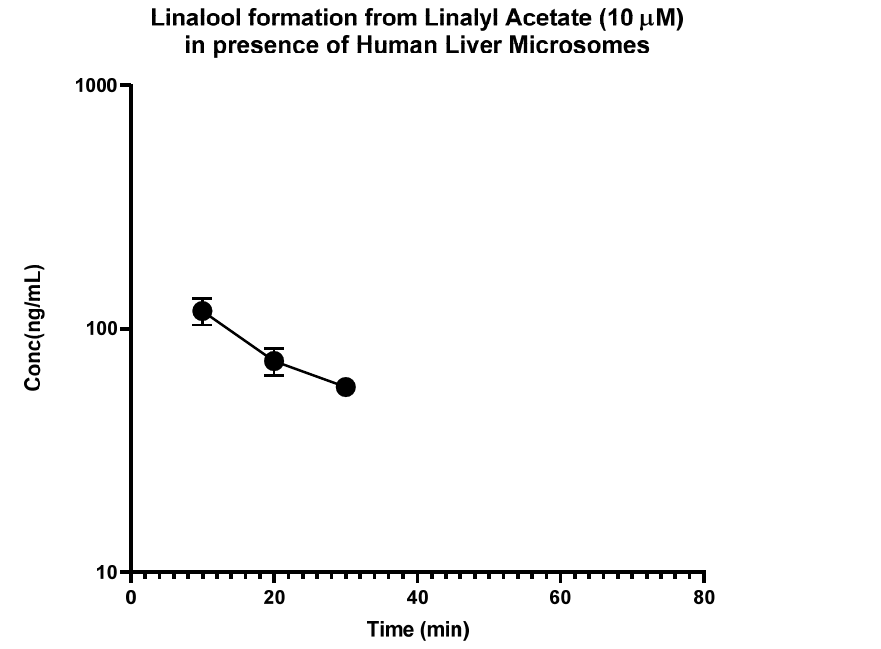
Molecules 2023 , 28 , x FOR PEER REVIEW Figure 2. Time-dependent metabolic depletion of linalool, linalyl acetate, and 7-hydroxy coumarin in human S9 fractions. Human S9 fractions were incubated with linalool, linalyl acetate, and 7-hydroxy coumarin (10 µ M) for 0–120 min in the presence of cofactors. The data are expressed as mean ± SEM.